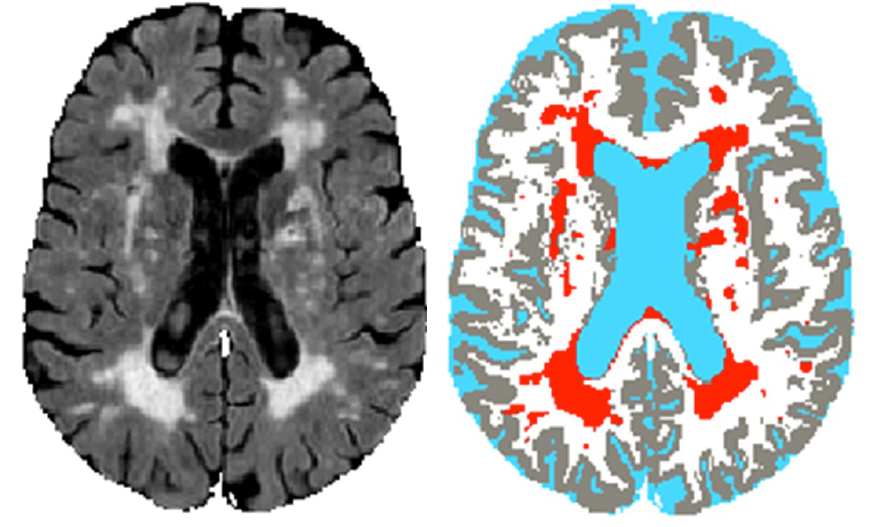
Figure 1. White matter lesions (WMLs) shown on magnetic resonance imaging: Fluid-attenuated inversion recovery image (left), tissue classification image (right; lesions in red). Images are for illustrative purposes only. The images were derived from a 3 Tesla MRI acquisition and processing for a participant in the parent study (NCODE), although this individual was not a participant of the present serum calcium